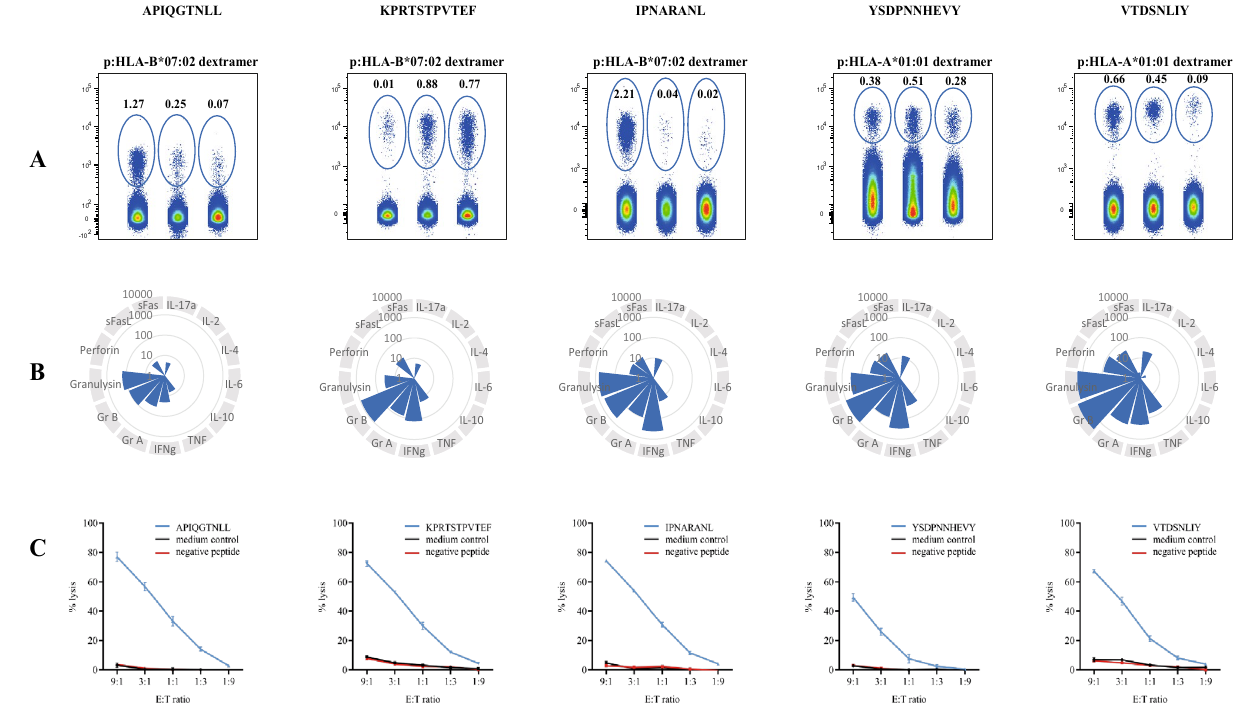
Figure 2. Detection and functional characterization of epitope-specific T cells from mumps patients ( A ) Flow cytometric ex vivo detection of epitope-specific T cells using p:HLA-I dextramers in PBMC samples of three HLA-B*07:02 patients (#03, #08 and #20; shown as respectively the left, middle and right data sets within the first 3 plots of ( A ) and three HLA-A*01:01-positive mumps patients (#04, #14 and #25), shown as respectively the left, middle and right data sets of the last 2 plots of ( A ). Frequencies of p:HLA-class I dextramer-positive cells are presented as percentage of total CD3 + /CD4 - /CD8 + cells. ( B ) Cytokine analysis of epitope-specific T cell lines derived from HLA-B*07:02- or HLA-A*01:01-positive mumps patients measured with a multiplex bead-based assay quantitating levels of interleukin-2 (IL-2), IL-4, IL-6, IL-10, tumor necrosis factor